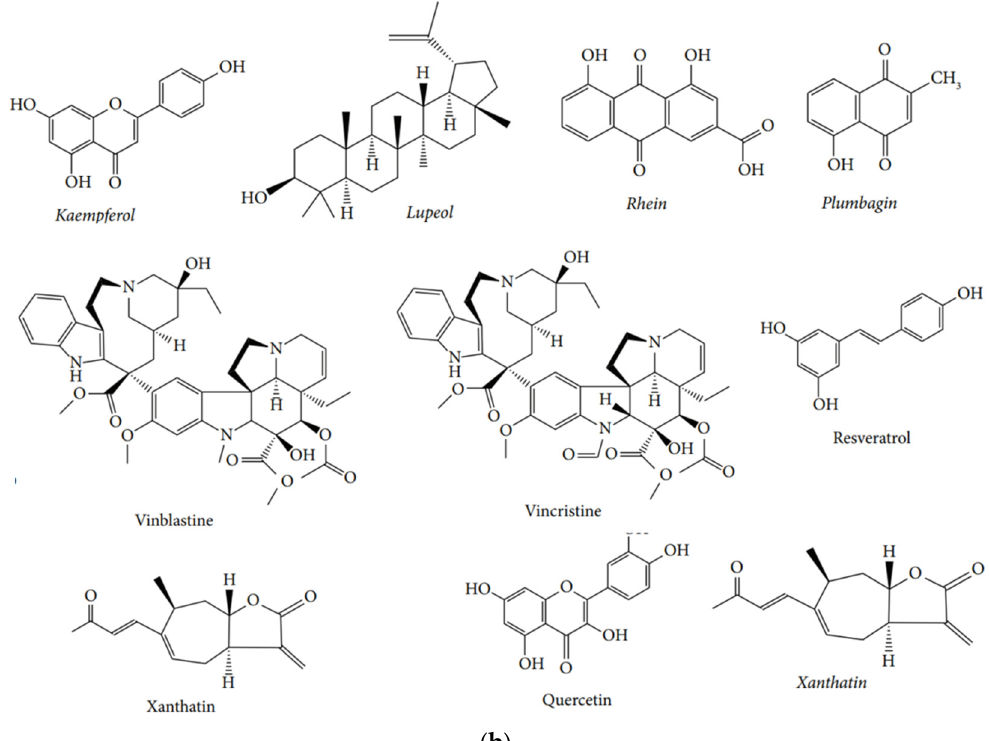
Figure 2. ( a ) Different phytochemicals used as therapeutic agents: aloe-emodlin, apigenin, baicalin, caffeic acid, crocetin, curcumin, and ellagic acid; ( b ) Different phytochemicals used as therapeutic agents: epigallocatechin-3-gallate (EGCG). luteolin, genistein, kaempferol, lupeol, Rhein, plumbagin, vinblastine, vincristeine, resveratrol, xanthatin, quercetin, and xanthin.